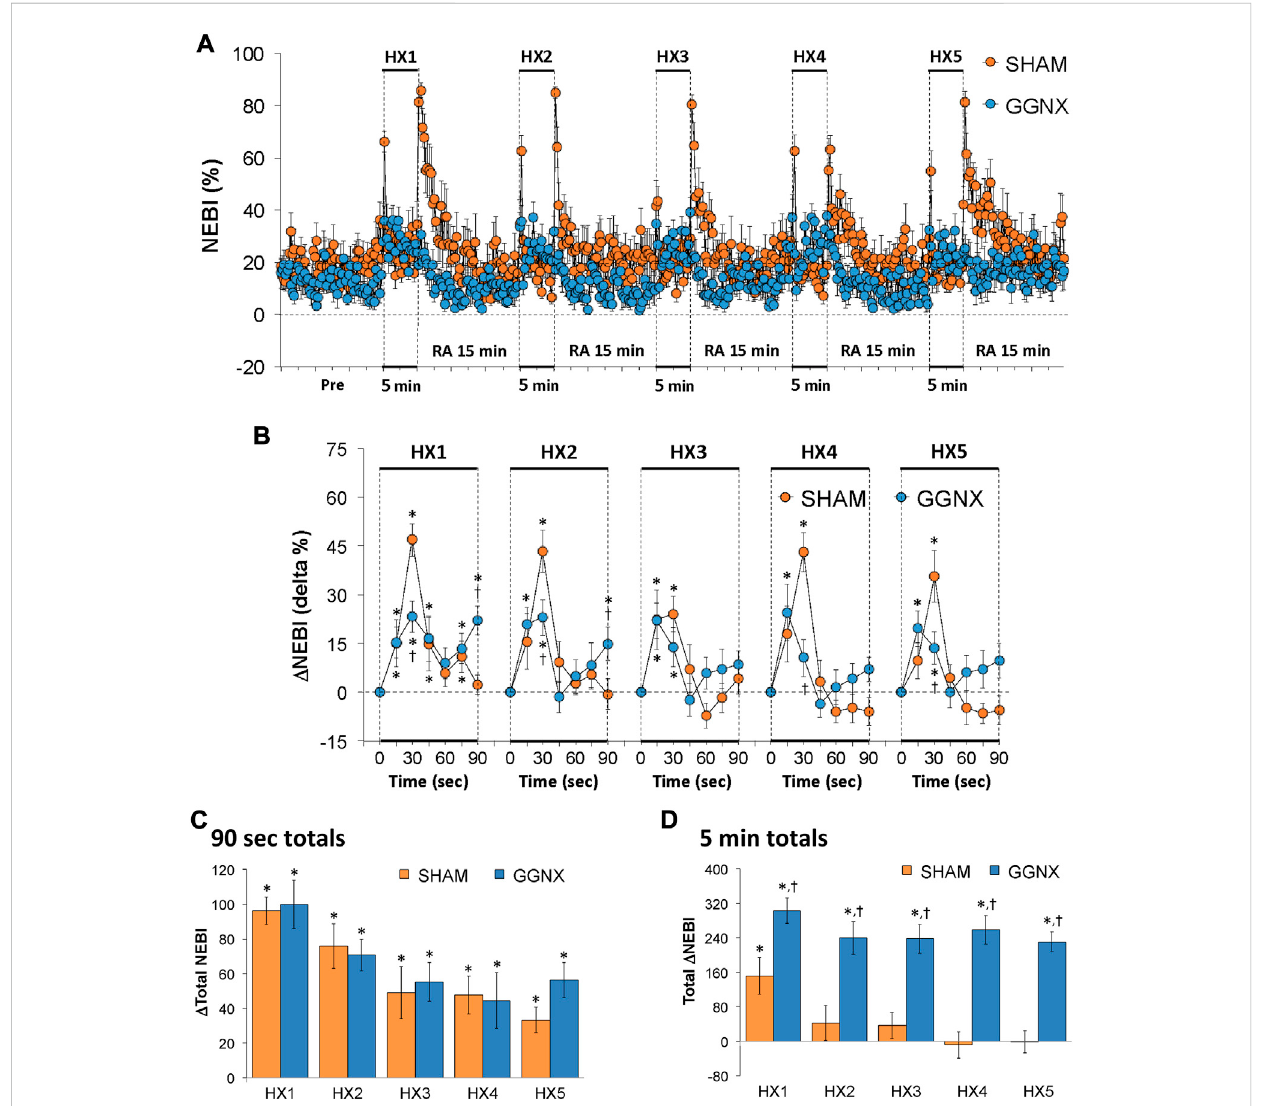
FIGURE 14 (A) Non-eupneic breathing index (NEBI) values in sham-operated (SHAM) rats and in rats with bilateral ganglioglomerular nerve transection (GGNX) before (Pre) and during fi ve hypoxic (HX, 10% O 2 , 90% N 2 ) gas challenges, each separated by 15 min of room-air (RA). (B) Arithmetic changes in NEBI duringthe fi rst90 sofHXgaschallenge.TotalchangesinNEBIduringthe fi rst90 s (C) andovertheentire5 min (D) ofHXgaschallenge.TheSHAMgroup had 10 rats. The GGNX group had 12 rats. Data are presented as mean ± SEM.* p < 0.05, signi fi cant response. † p < 0.05, GGNXrats versus SHAM